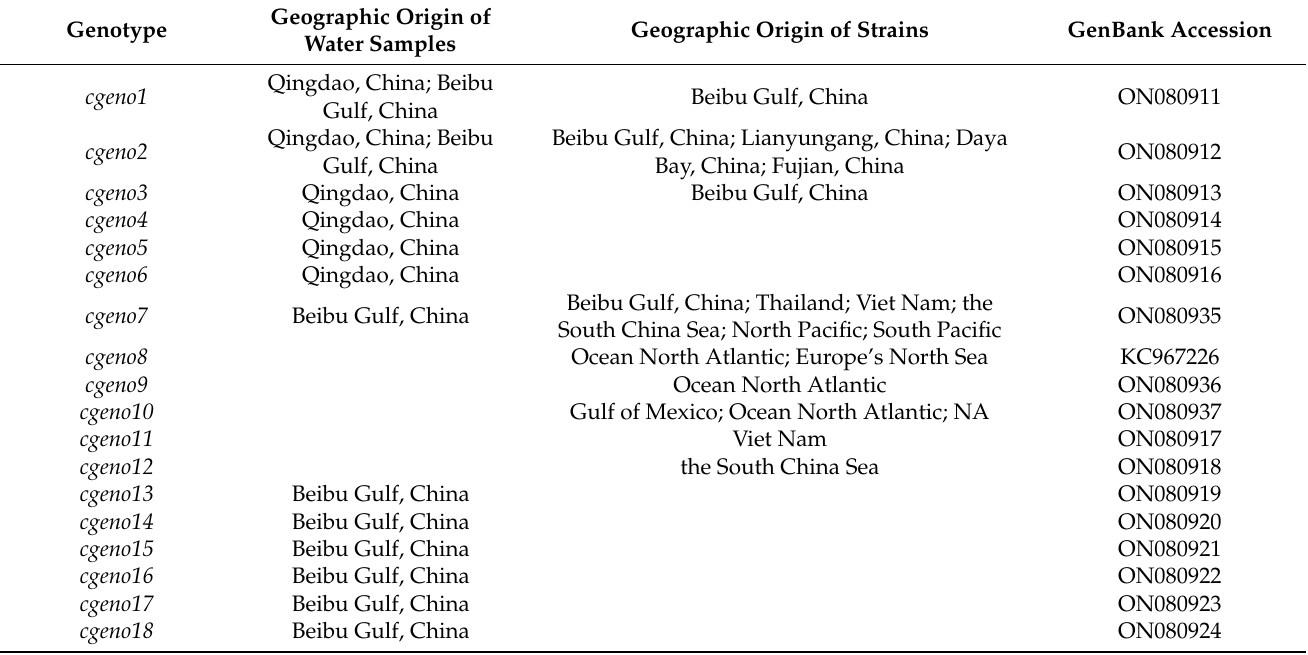
Table 2. Geographic origin and GenBank accession of cox1